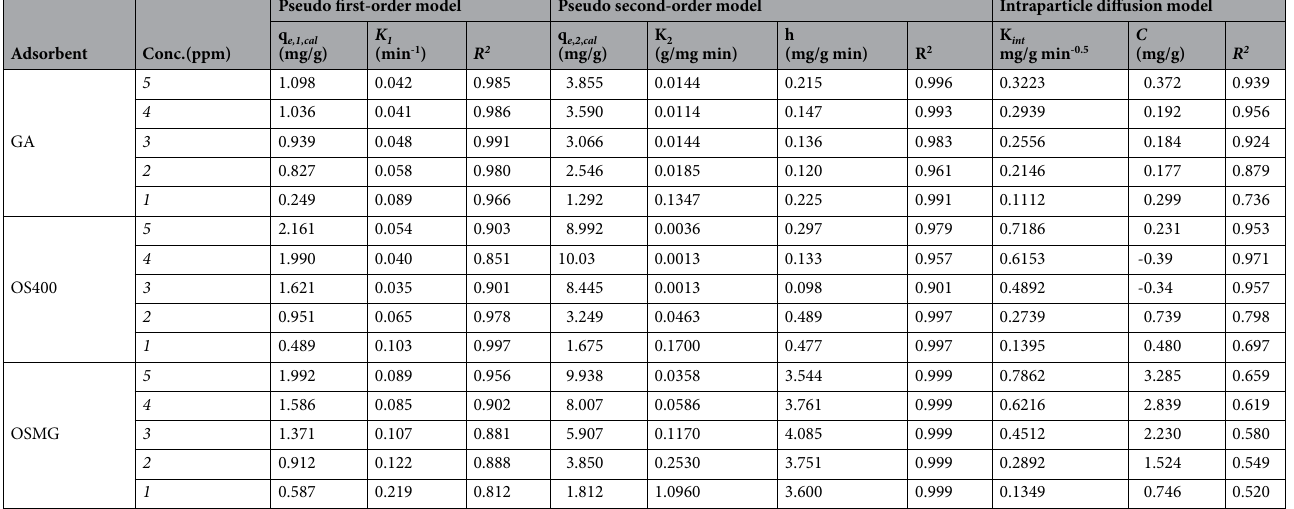
Table 7. Kinetics parameters of models on GA, OS400 and OSMG adsorbents.